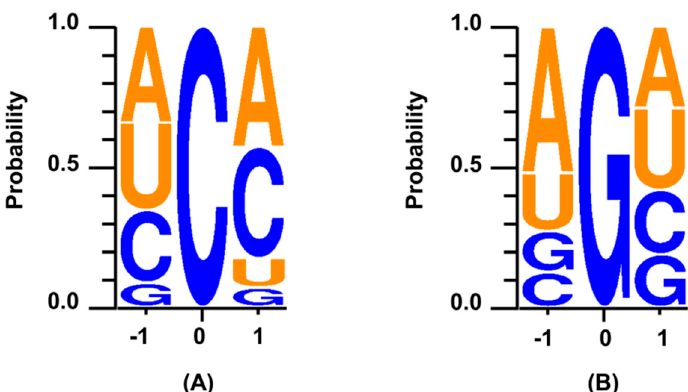
Figure 3. Analysis of sequence context for the non-canonical editing events. The figure shows the edited base in the middle (position 0) and the probability of the bases one base upstream (position − 1) and downstream (position + 1). ( A ) For C-to-A edited miRNAs, adenosine was a preferred base downstream ( p = 0.02) and guanosine was avoided on either side of the edited cytosine ( p = 0.02 and p = 0.009). Uracil was also not preferred downstream to the edited cytosine ( p = 0.04). ( B ) For G-to-U-edited miRNAs, adenosine was the preferred base both upstream ( p = 0.002) and downstream of the edited guanosine.